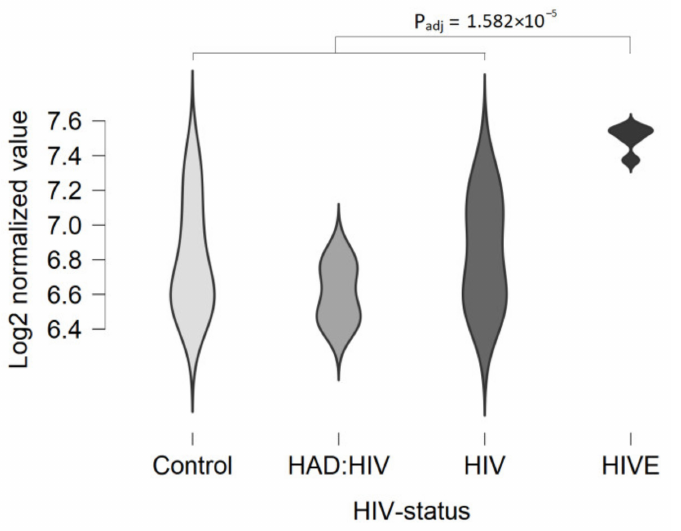
Figure 4. TAAR5 expression up-regulation in the white matter in patients with HIV-associated encephalitis (microarray-generated dataset GSE35864). Control—non-HIV-infected subjects ( n = 6), HAD:HIV—HIV-infected subjects with HIV-associated dementia ( n = 7), HIV—HIV-infected subjects ( n = 6), HIVE— subjects with HIV encephalitis ( n =